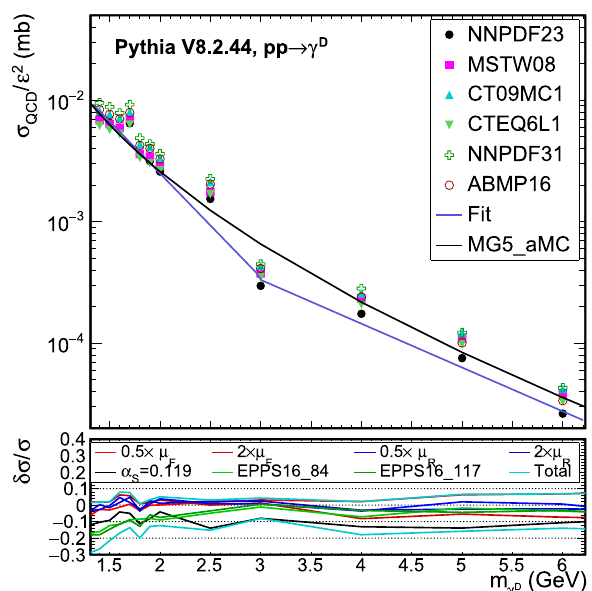
Fig. 5 QCD production cross section at LO as a function of m γ D . The fit function is described in Eq. (9). The upper pad shows the impact of different PDF sets [55,57–60]. The lower pad shows the relative uncer- tainties from several theoretical uncertainty sources on the cross section calculated by PYTHIA, and their sum in quadrature under